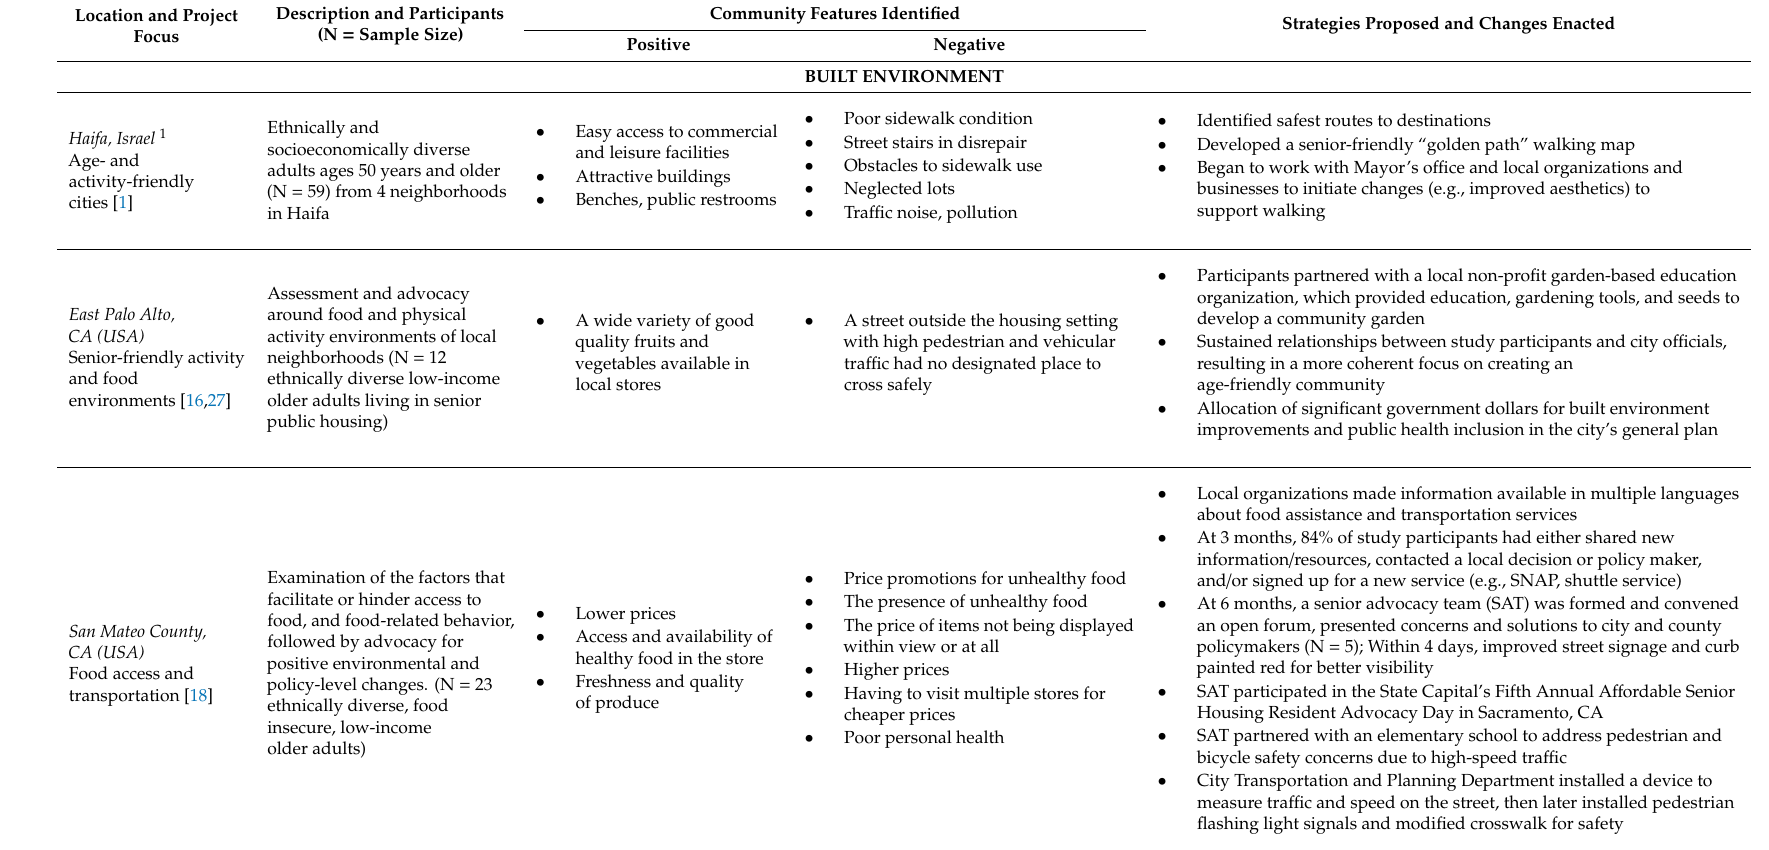
Table 1. Examples of Our Voice older adult projects completed or in